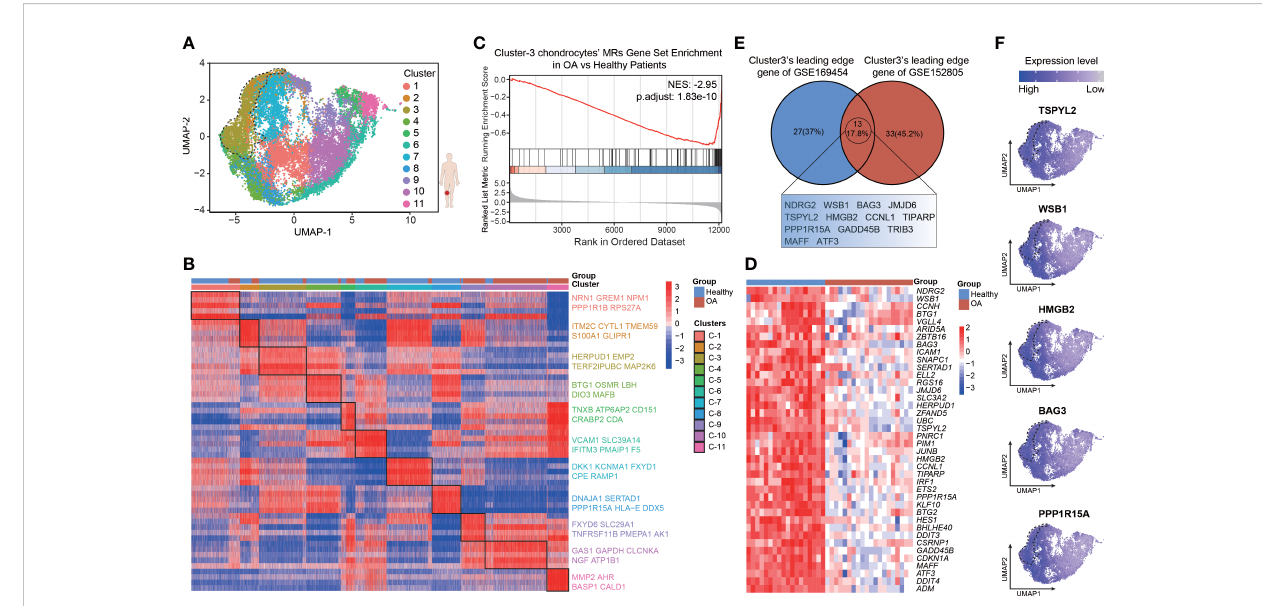
FIGURE 4 Validation for the robustness of leading-edge proteins based on VIPER-inferred protein activity matrix. (A) Visualization of umap colored according to cell clusters for VIPER-Inferred protein activity across 6 cartilage samples. (B) Heatmap of the scaled expression of top 5 master regulator proteins of various cell clusters from inferred proteomic data. (C) Gene set enrichment analysis (GSEA) of top 100 master regulator proteins of cluster3 from inferred proteomic data in ranked differential expressed genes list of bulkRNA-seq data from 20 patients with OA versus 18 patients with normal cartilage. (D) Heatmap of leading-edge protein set of protein activity-based cluster 3 from GSEA analysis. (E) Venn plots showing the shared leading- edge proteins of protein activity-based cluster 3 between GSE169454 and GSE152805. (F) Dot plots showing the top 5 leading-edge protein of cluster 3 based on VIPER-inferred protein activity on the